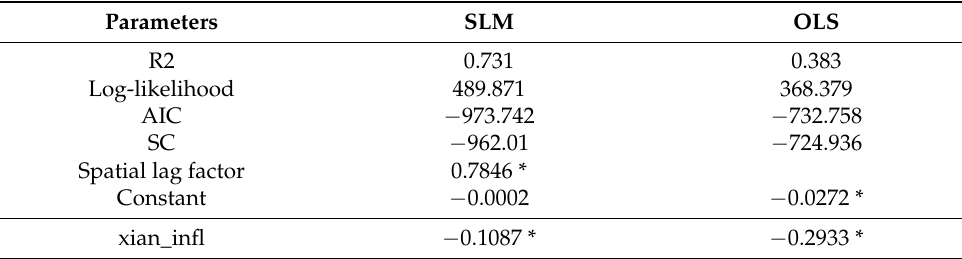
Table 2. Fitting results of OLS and